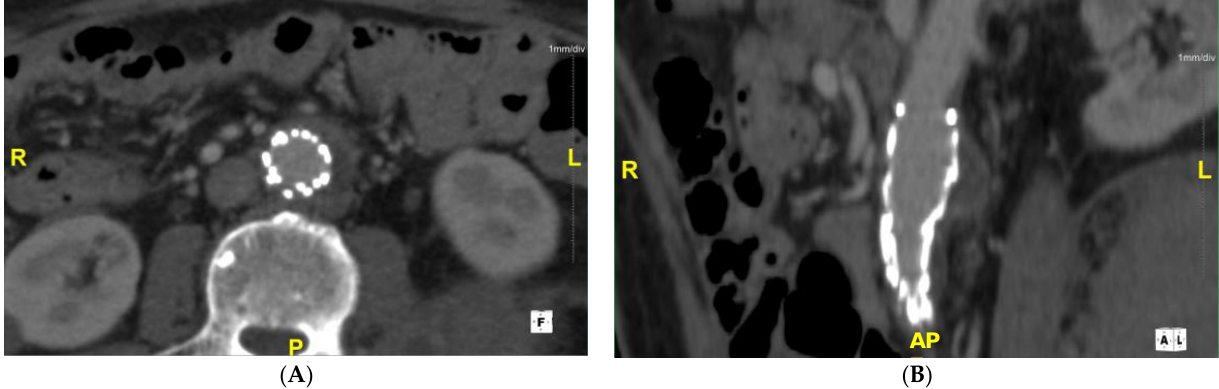
Figure 3. CT scan ( A ) axial view and ( B ) coronal view at 6 weeks after endovascular repair, demonstrating a stable sac without any noticeable evidence of mycotic aneurysm progression or endoleak. R = right; L = Left; P = Posterior, AP = Anterior Posterior.